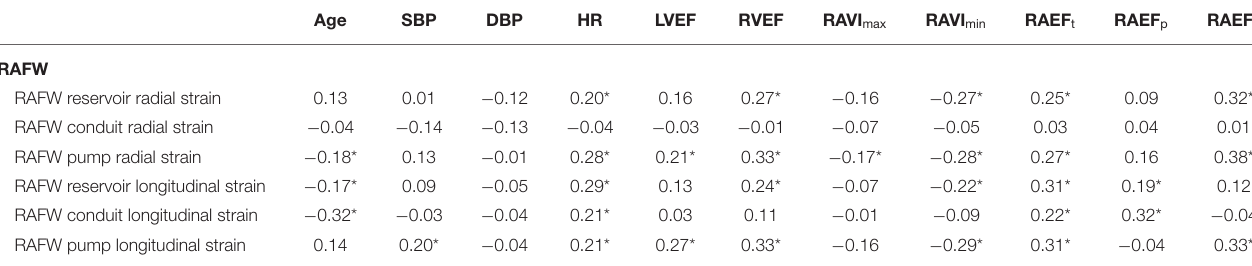
TABLE 4 | Correlation between right atrial strains and baseline variables.